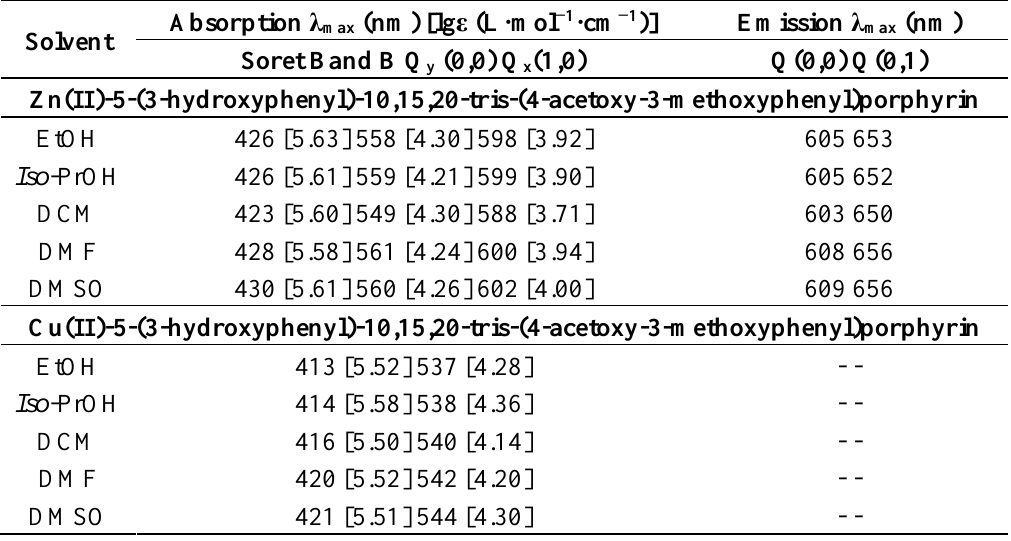
Table 1. Absorption and emission data of the porphyrinic complexes in various solvents ( c = 2.5 × 10 −6 M, λ ex = 420 nm).